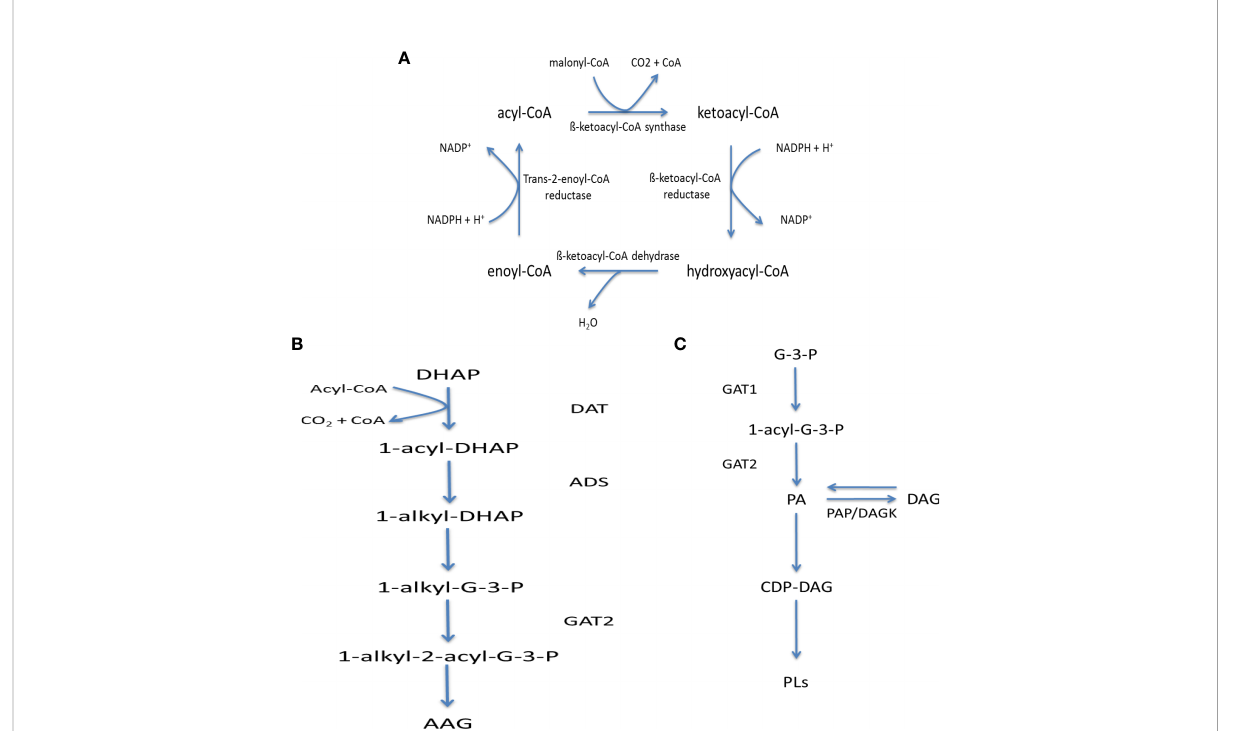
FIGURE 6 Fatty acid metabolism in kinetoplastids: (A) Fatty acid elongase mechanism, (B) Acyl-alkyl glycerol synthesis and (C) Phosphatidic acid synthesis and metabolism. Key – ADS, 1-Alkyl-dihydroxyacetonephosphate synthase; DAT, Dihydroxyacetonephosphate acyltransferase,; DAGK, DAG kinase; GAT1, Glycerol-3-phosphate acyltransferase; GAT2, 1-Acyl-sn-glycerol-3-phosphate acyltransferase; PAP, Phosphatidic acid phosphatase; AAG, Alkyl-acyl glycerol; CoA, Co-enzyme A; DAG, Diacylglycerol; G-3-P, Glycerol-3-phosphate; PA, Phosphatidic Acid; PLs,